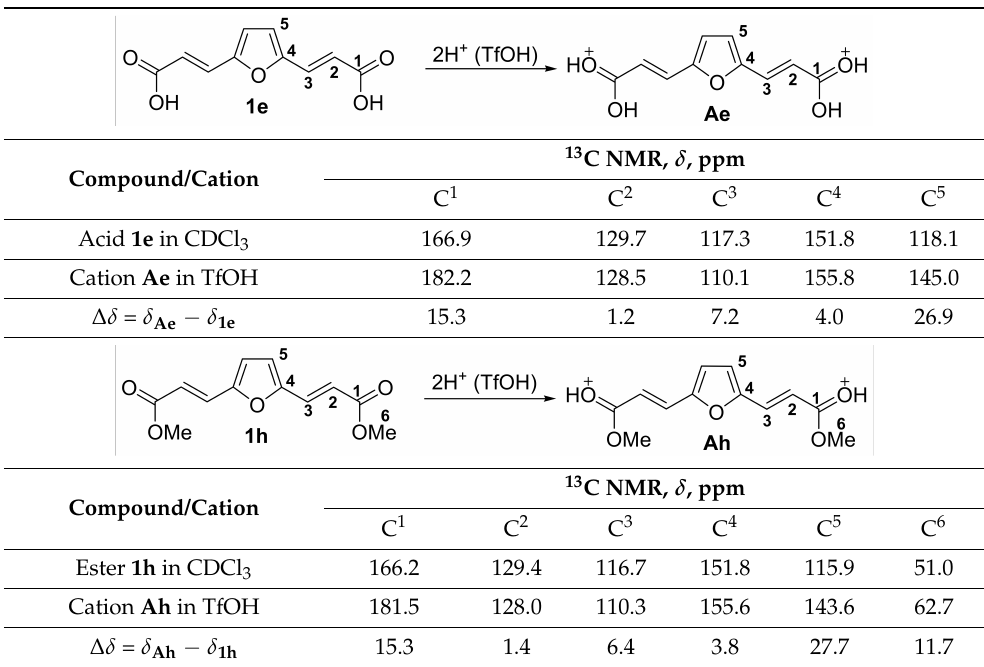
Table 4. 13 C NMR data of starting compounds 1e and 1h and their protonated forms Ae and Ah generated in